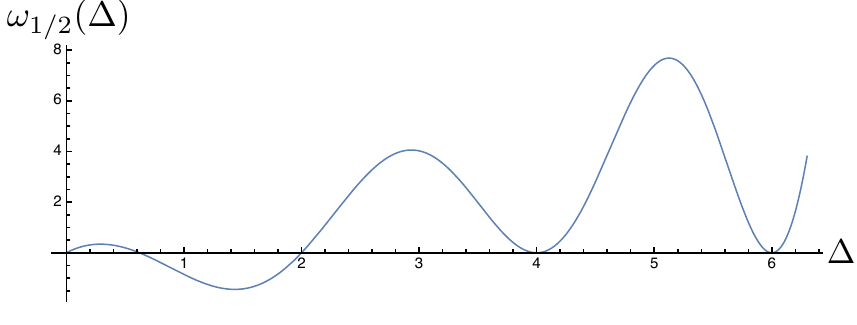
Figure 6 . The action of the extremal functional for (cid:1) = 1 = 2, given by equation (4.34). which turns out to be the correct formula. The function ! 1 expected, ! 1 ((cid:1)) has double zeros at (cid:1) = 2 + 2 j , j 2